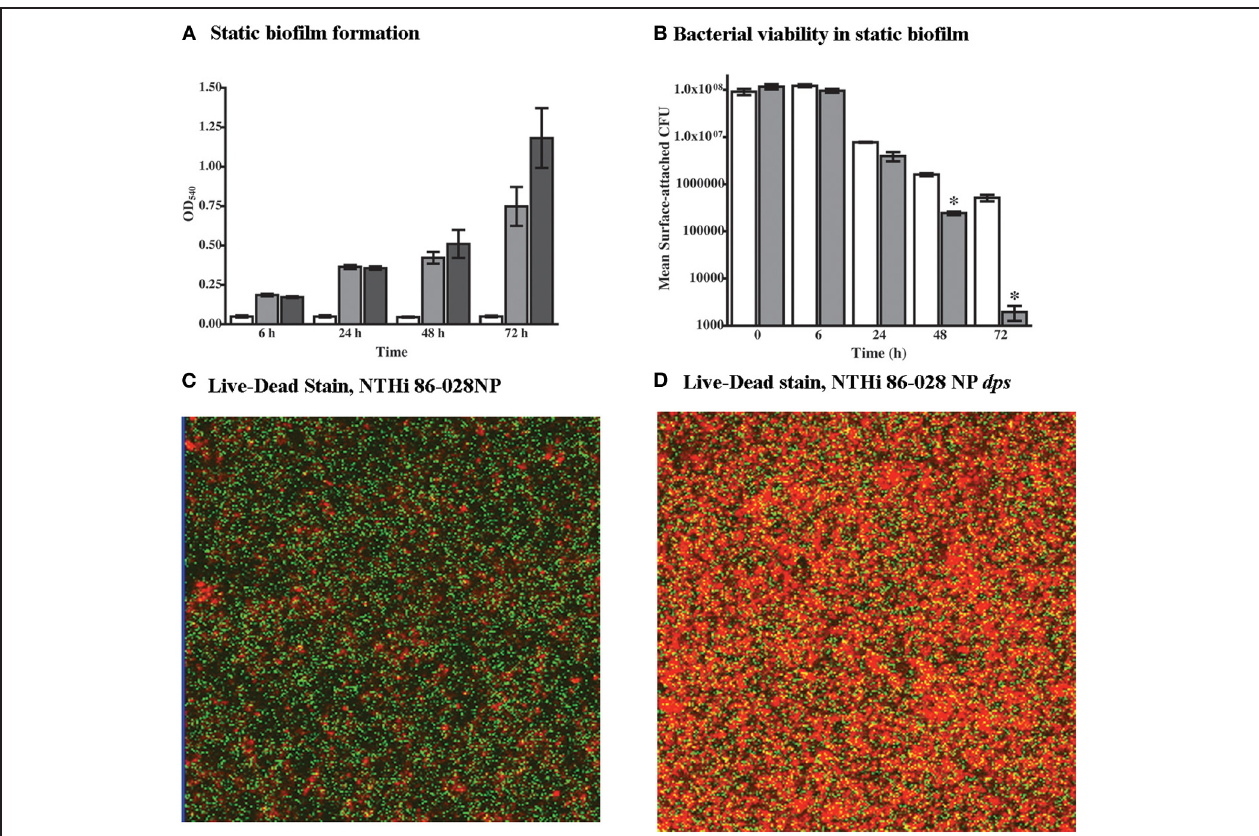
86-028NP dps (shaded bars) was assessed by plate-count of biofilm attached to plastic surface. Values are means of four independent replicates; statistical significance was determined by analysis of variance and post-hoc analysis using Bonferroni test. (C) Viability staining of NTHi 86-028NP biofilm in continuous-flow system 24h post-inoculation. (D) Viability staining of NTHi 86-028NP dps biofilm in continuous-flow system 24h post-inoculation.